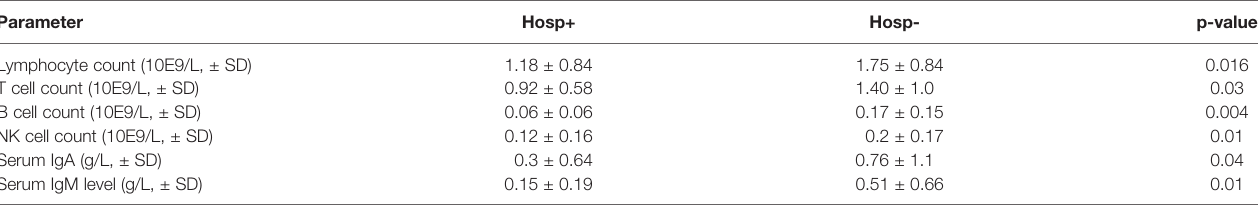
(SD, standard deviation; Hosp+, hospitalized patients; Hosp-, non-hospitalized patients).